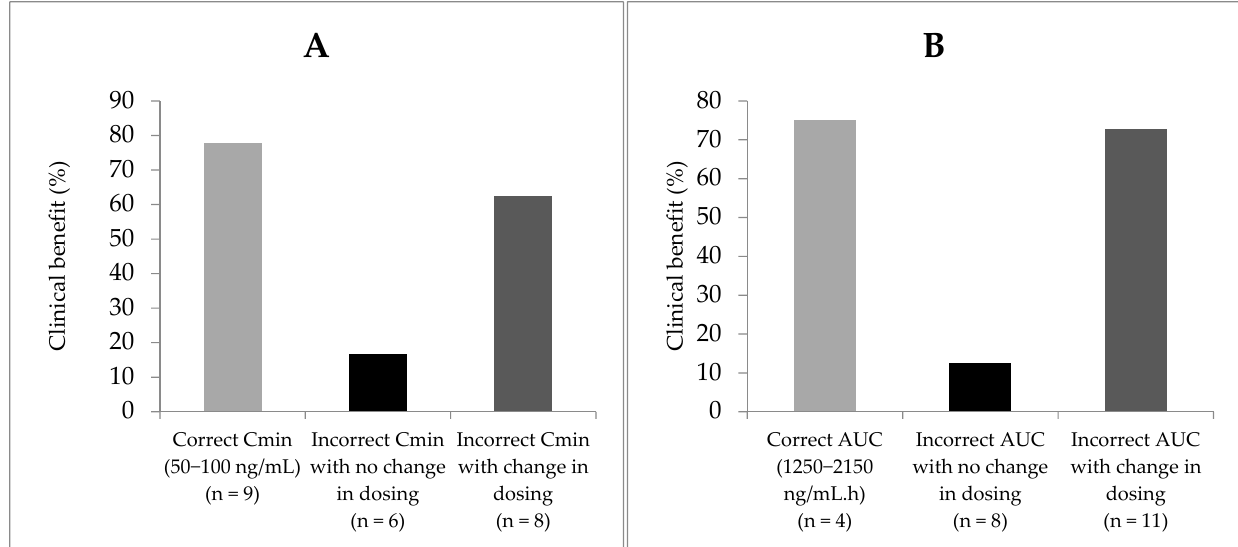
Figure 5. Clinical benefit in patients depending on their baseline exposure values. ( A ) Trough concentrations, ( B ) AUC and the subsequent change in dosing. Table 3. Clinical benefit as measured by RECIST criteria at 3 months in patients depending on their baseline exposure values ( A : target = trough concentrations, B : target = AUC) with or without change in dosing.